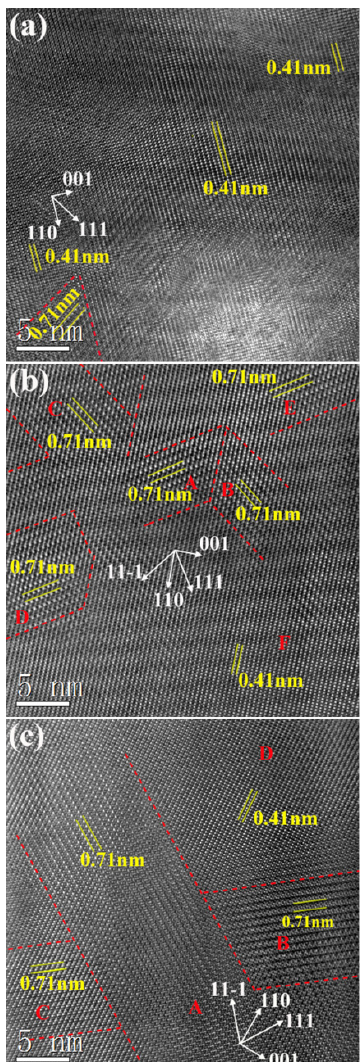
Figure 8. Lattice image viewed along the [110] zone axis for the ordered BZT ceramics: ( a ) the sintered sample without annealing; ( b ) the annealed sample at 1300 ◦ C for 12 h; ( c ) the annealed sample at 1400 ◦ C for 12 h.